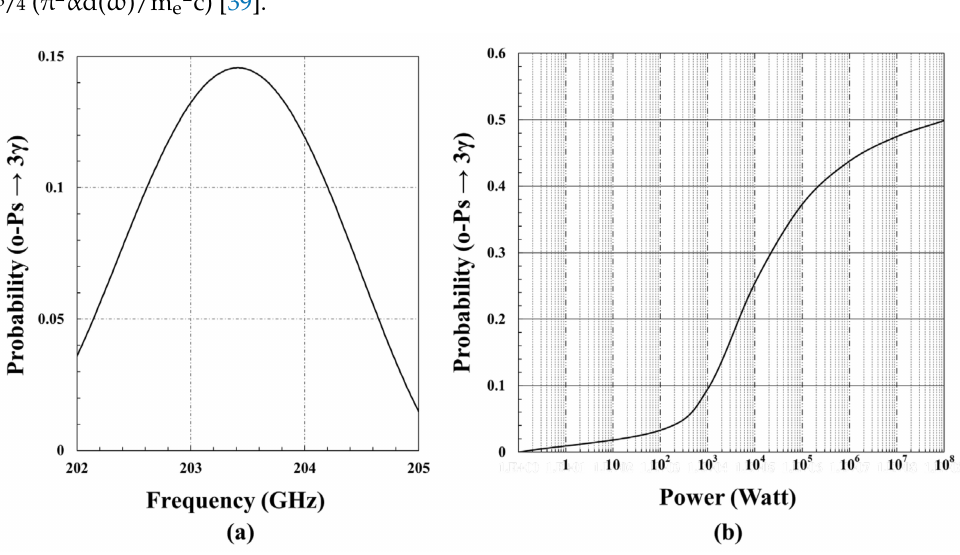
Figure 4. Transition probabilities for o-Ps(3 γ ) by using theoretical calculations according to ( a ) operating frequencies and ( b ) output